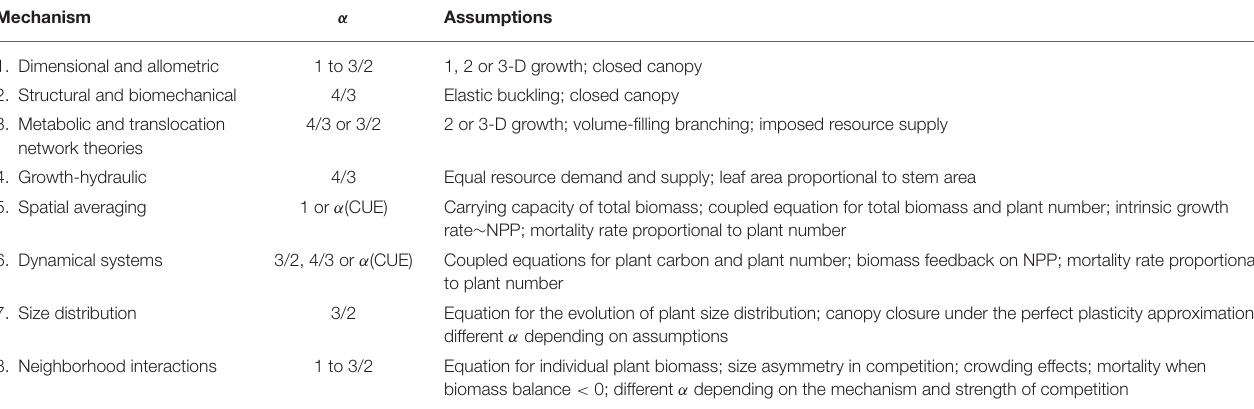
TABLE 1 | Summary of the studied mechanisms leading to a different exponent α (Equation 2) along with the most pertinent equations and assumptions used. Mechanism α